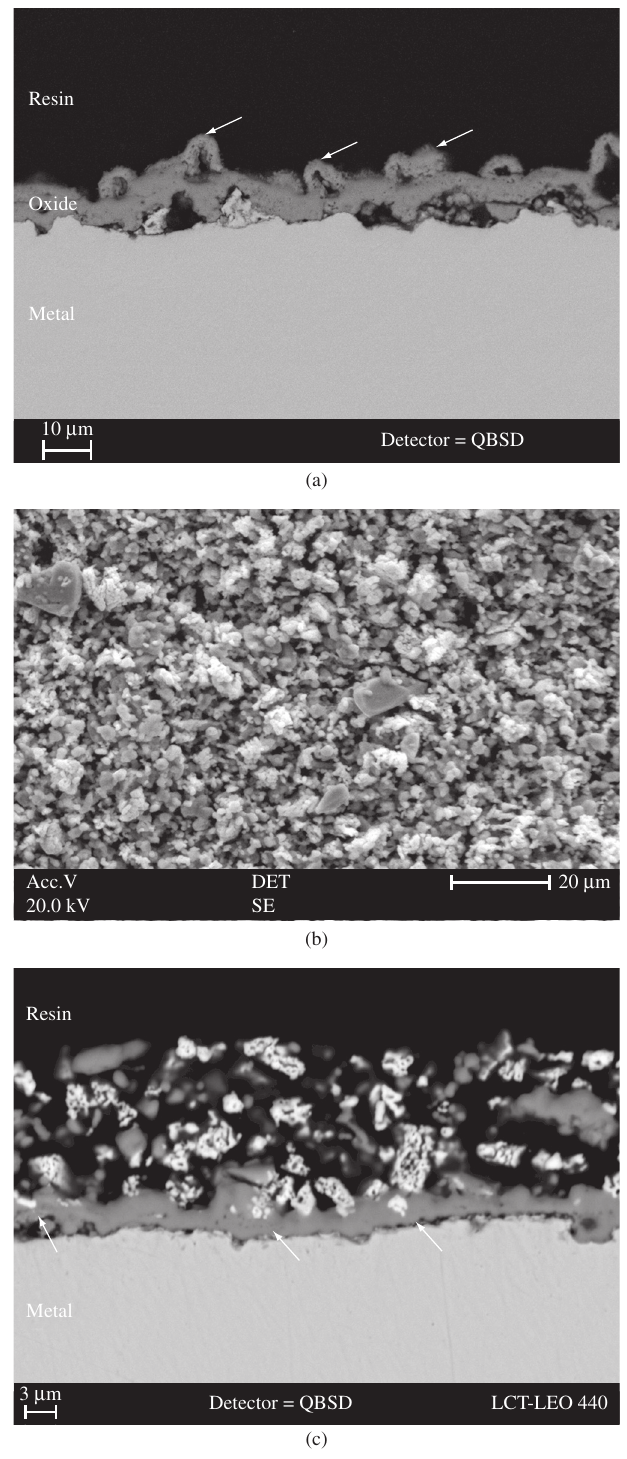
Figure 2. Oxidation curves of alloys Fe-20Cr and Fe-20Cr-4Al with and without LaCrO coating. 3